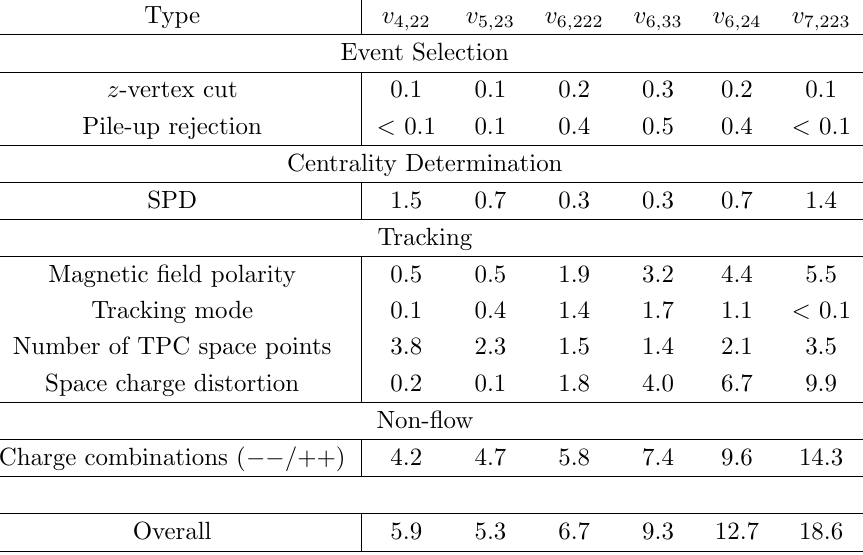
Table 2 . Relative systematic uncertainties of the harmonic projections v n;mk